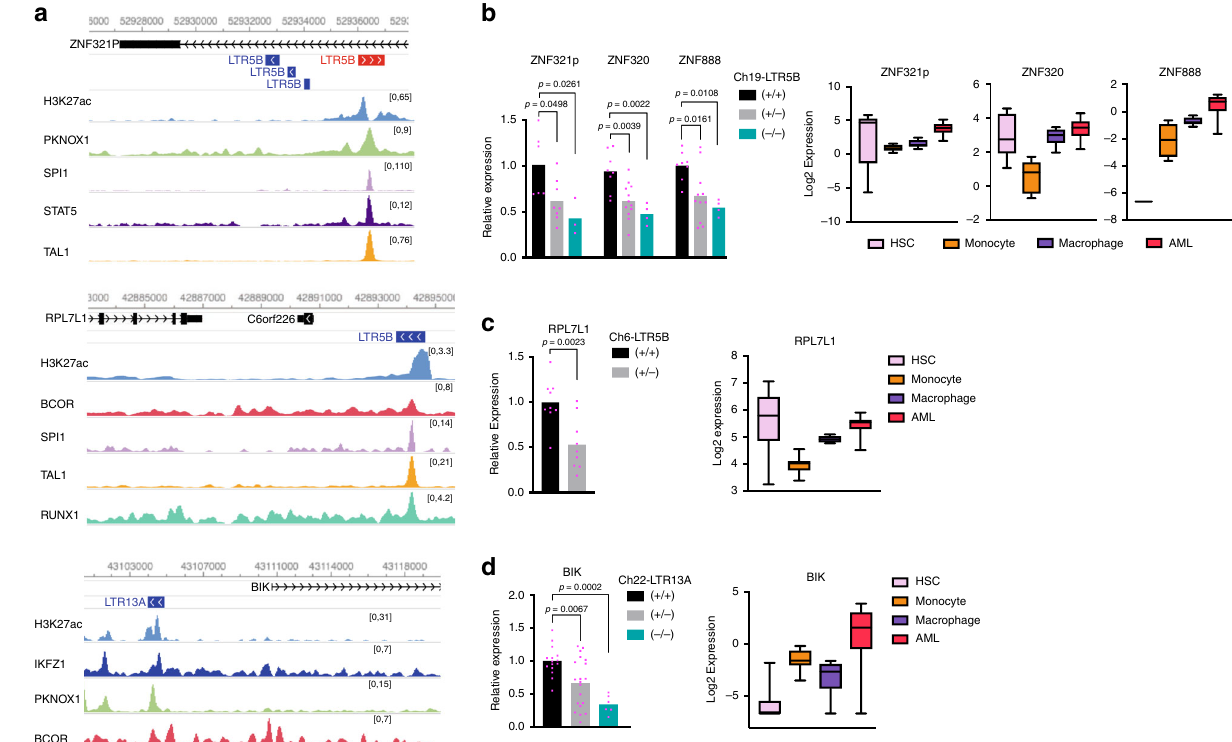
Fig. 4 Regulatory ERVs modulate host gene expression. a Genome browser view of three candidate ERVs, showing H3K27ac and TF ChIP-seq tracks in K562 cells. b – d Expression of nearby genes (left) in the excision clones of the indicated ERVs. Bars represent mean values. Data points are from multiple samples (collected every 2 – 4 days) from each independently derived clone, as follows: four samples from 2 + / + , 3 + / − and 1 − / − clones ( b ), 3 samples from 3 + / + and 3 + / − clones (c), and 8 samples from 2 + / + , 3 + / − and 1 − / − clones ( d ). P values are from one-way ANOVA with Tukey ′ s multiple- comparison test ( b , d ) or two-tailed t test ( c ). Expression of the indicated ERV vicinity genes (right) in HSC ( n = 6), monocyte ( n = 8), macrophage ( n = 6), and AML ( n = 27) samples (boxes indicate fi rst, second (median) and third quartiles; whiskers indicate data within 1.5× of the interquartile range). Source data are provided as a Source Data fi le for ( b – d